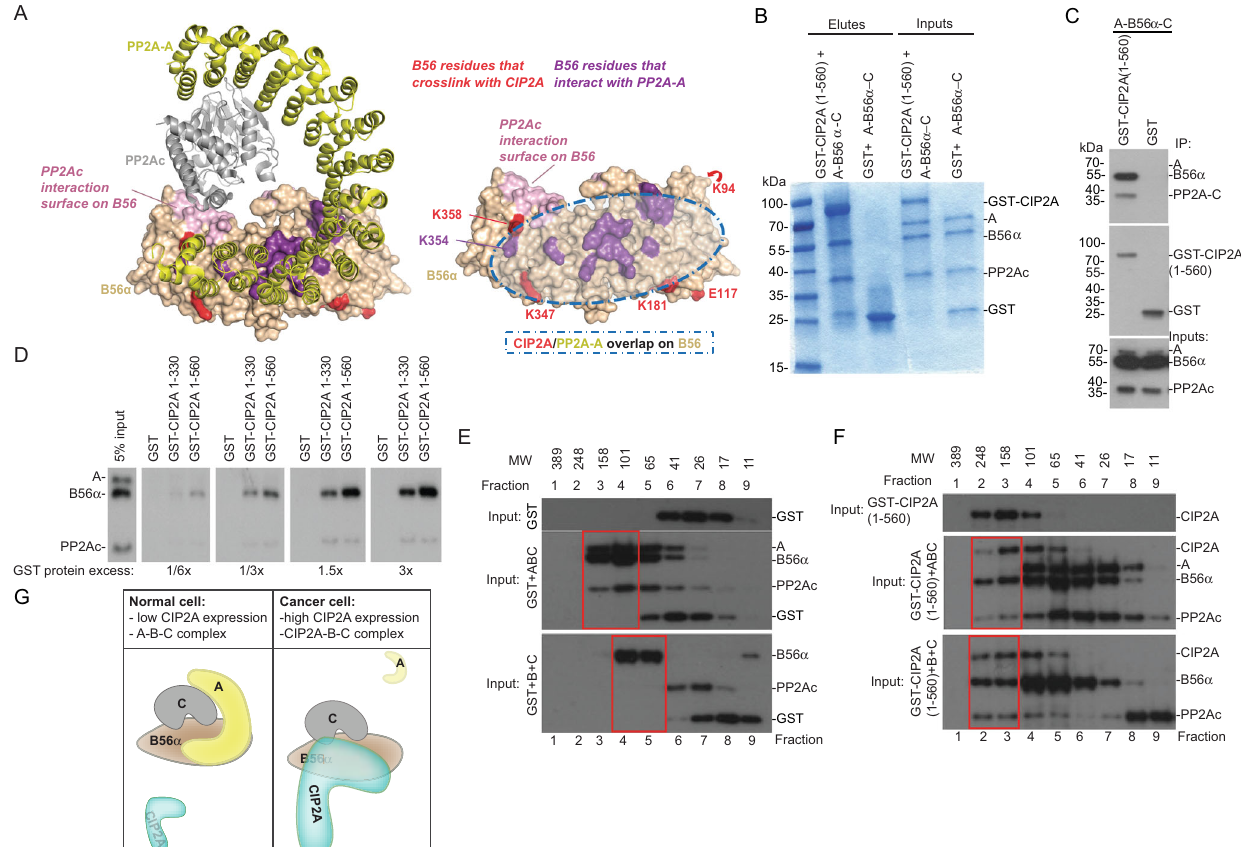
Fig. 4 | CIP2A displaces PP2A-A from PP2A-B56 α trimer and interacts directly with PP2Ac. A B56 α sites identi fi ed in inter-molecular cross-links with CIP2A overlap with B56 α contact sites with the scaffolding A subunit (PDB: 6NTS). A subunitisyellow,catalyticsubunitisgrey,andB56 α iswheat.TheXL-MScross-links between CIP2A and B56 α are in red. PP2A-A and PP2Ac interaction sites with B56 α are shown in magenta, and light purple, respectively (based on refs. 40,41 ). The overlapbetweenPP2A-AandCIP2AinB56 α surfaceisindicatedastransparentoval shape in the right panel. B Coomassie stained SDS-PAGE of PP2A trimer compo- nents interacting with CIP2A(1-560) after incubation with the pre-assembled PP2A- B56 α heterotrimer (A-B56 α -PP2Ac). A=PP2A-A; C=PP2Ac. Representative image from four experiments is shown. C Western blot analysisof the similar experiment as in ( B ). The different intensities of the Western blot signals between PP2A-A ( A ), B56 α , and PP2Ac inthe input (and between B56 α , and PP2Ac inthe eluates),is due to differential af fi nities of the antibodies used simultaneously to blot the mem- branes. N =3 biological repeats. D GST pull-down assay for PP2A trimer-GST-